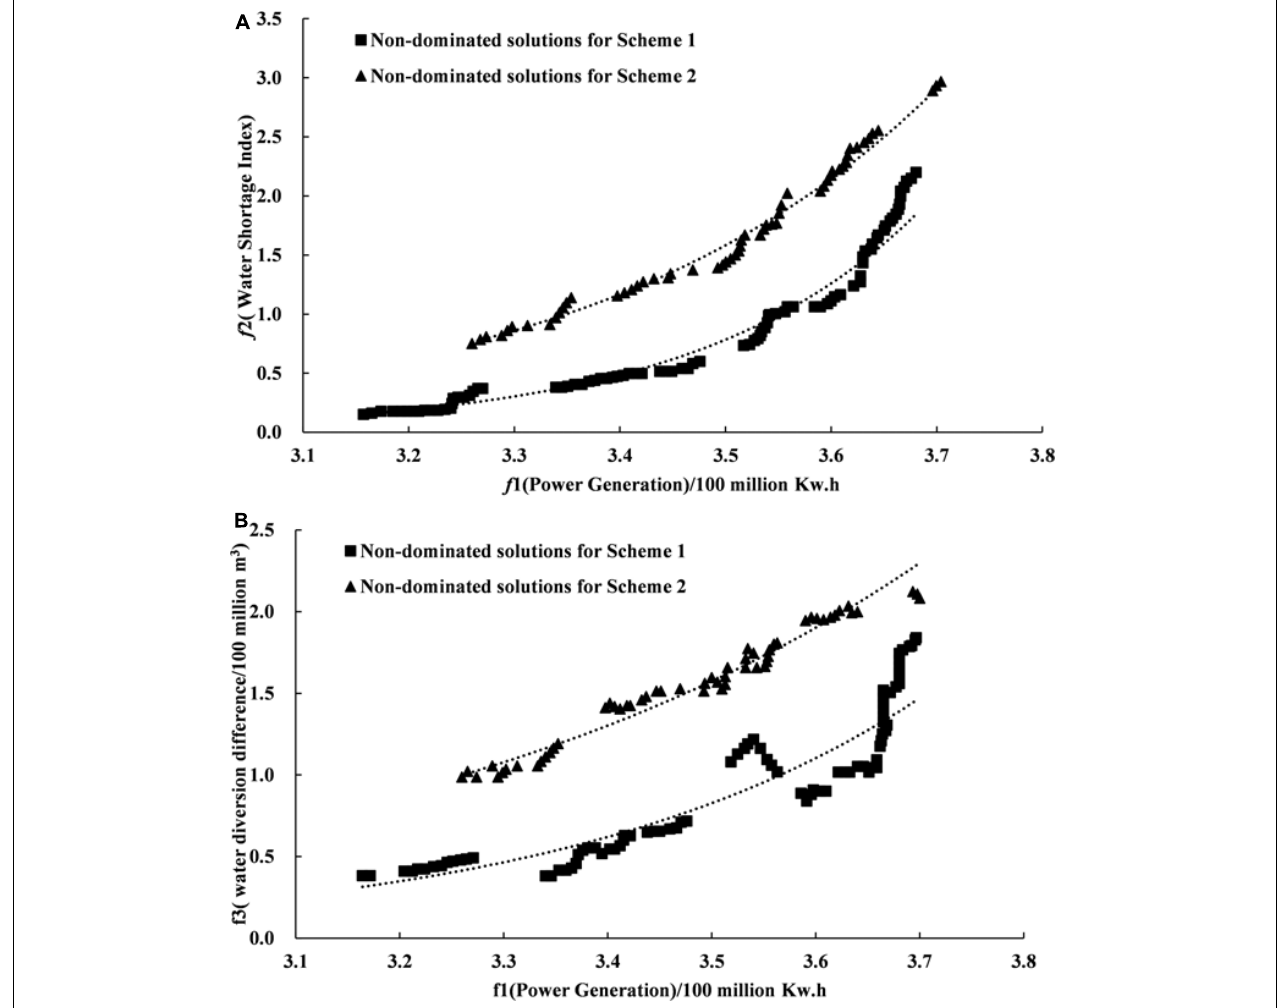
FIGURE 6 | The frontier projection of Pareto solution set. (A) Pareto frontier projection of power generation target and water supply target. (B) Pareto frontier projection of power generation target and water diversion